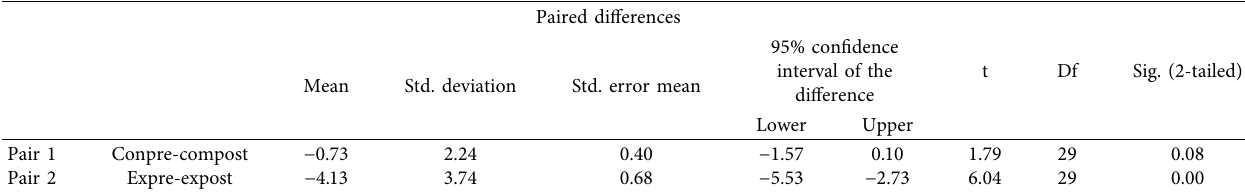
Table 10: Paired samples statistics of the experimental and control groups in the vocabulary pre- and posttests. Paired differences